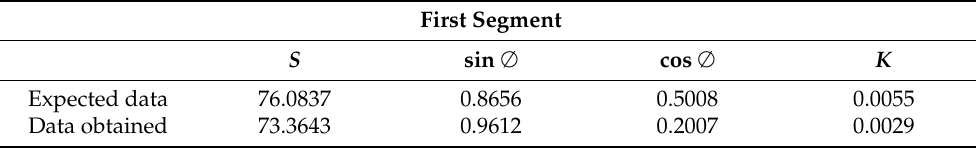
Table 5. Comparison of the neural network results for the first segment. Source: authors. First Segment S sin ∅ cos ∅ Expected data